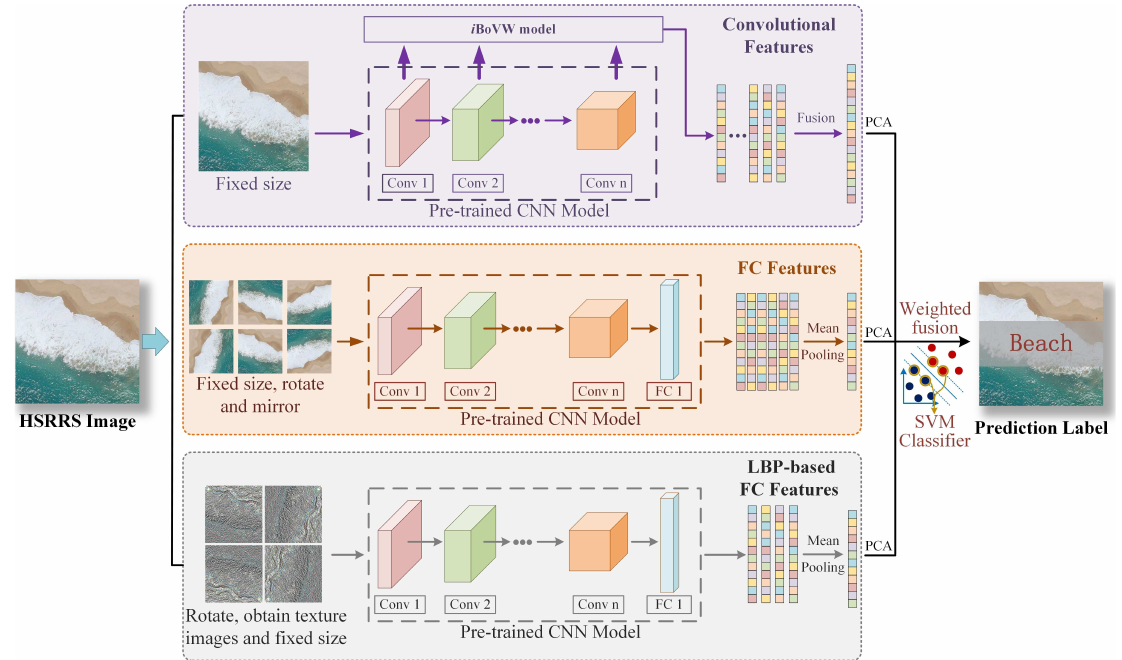
Figure 3. Framework of the proposed CTFCNN method. HSRRS—high spatial resolution remote sensing; CNN—convolutional neural network; FC—fully connected; PCA—principal component analysis; SVM—support vector